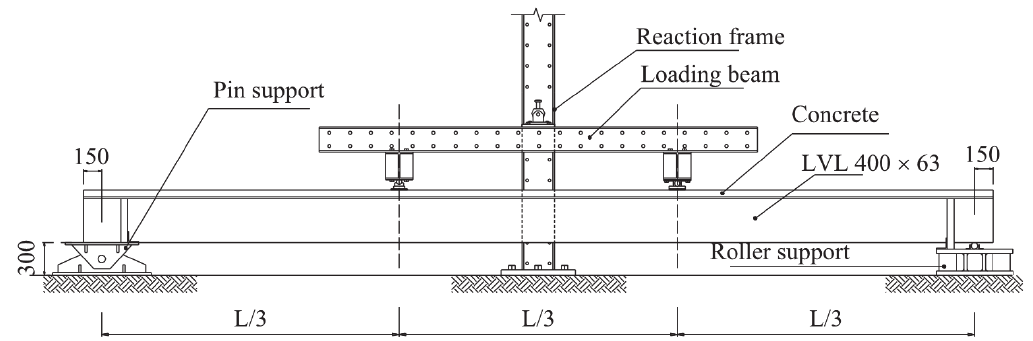
Figure 1: Four-point bending test of a TCC beam (dimensions in mm)[14].